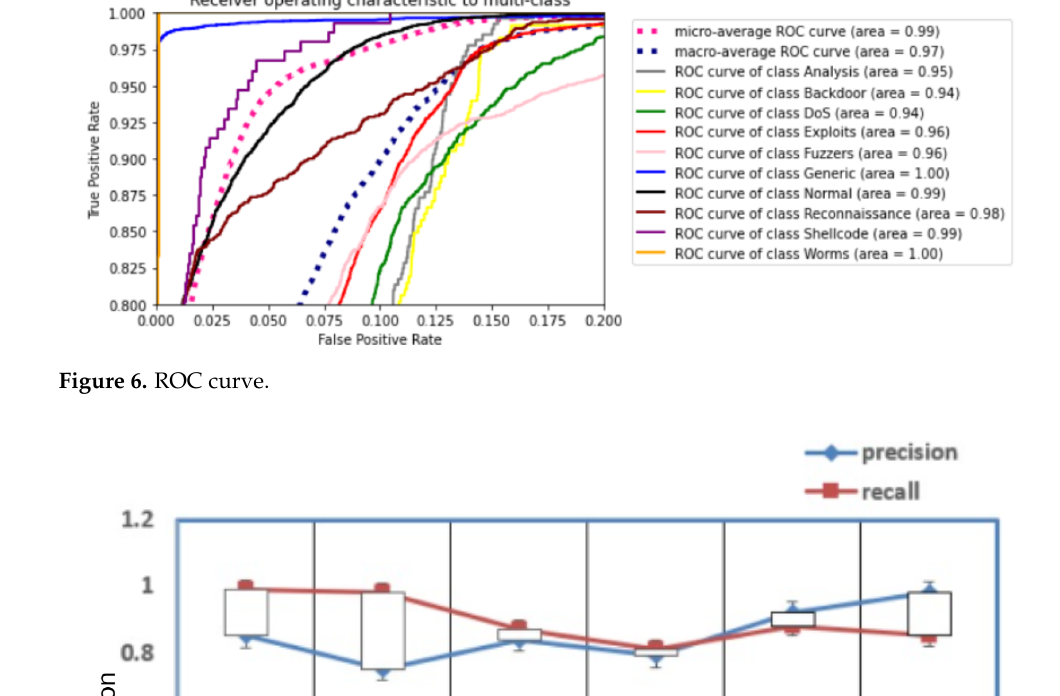
Figure 8. Statistical